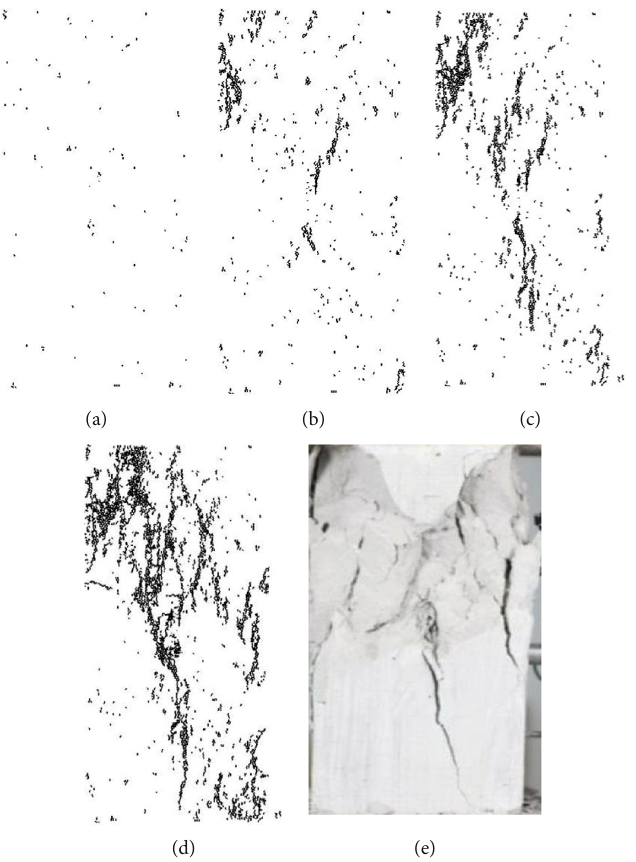
Figure 10: The process of crack initiation and development at the bend number of 7. (a) ε = 0 : 0067 . (b) ε = 0 : 0122 . (c) ε = 0 : 0183 . (d) ε = 0 : 235 . (e) Instable failure.